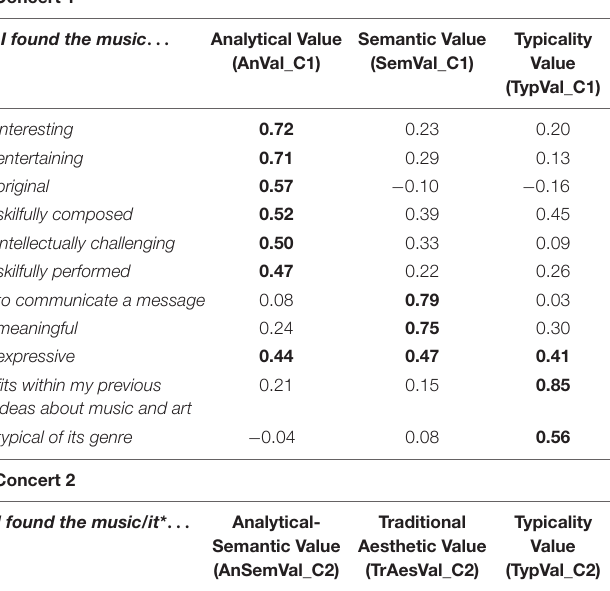
TABLE 3 | Factor loadings for exploratory factor analysis with varimax rotation of aesthetic judgment criteria from Concerts 1 and 2. Concert 1 I found the music